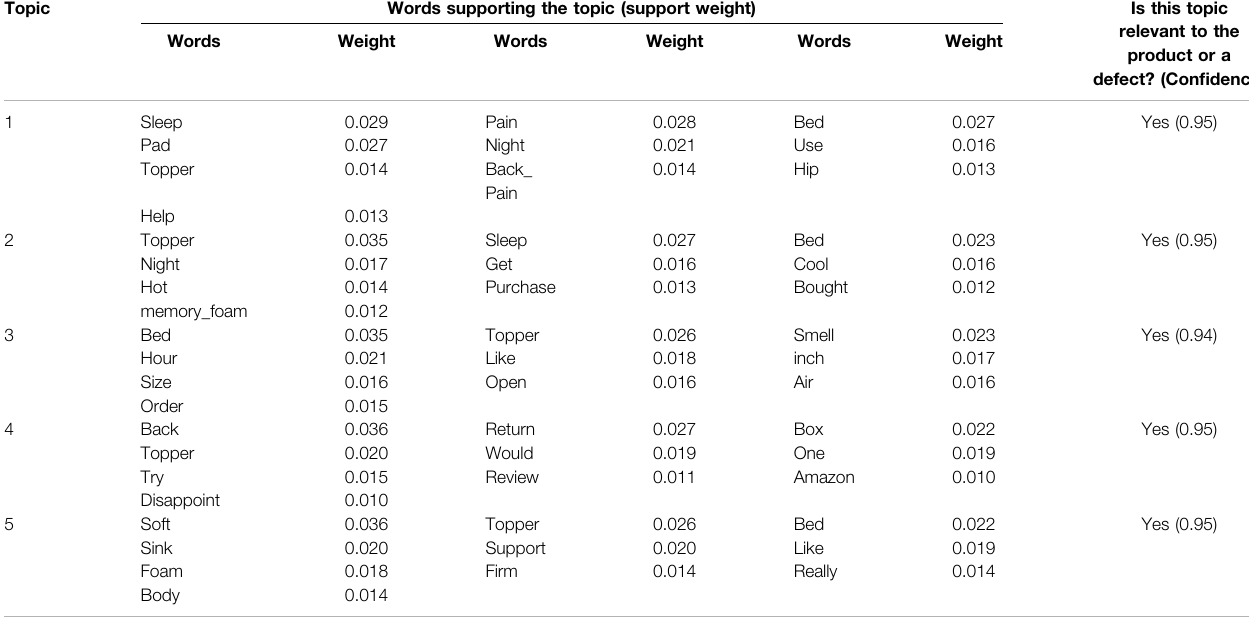
TABLE 4 | Topic model words for LINENSPA Mattress topper.